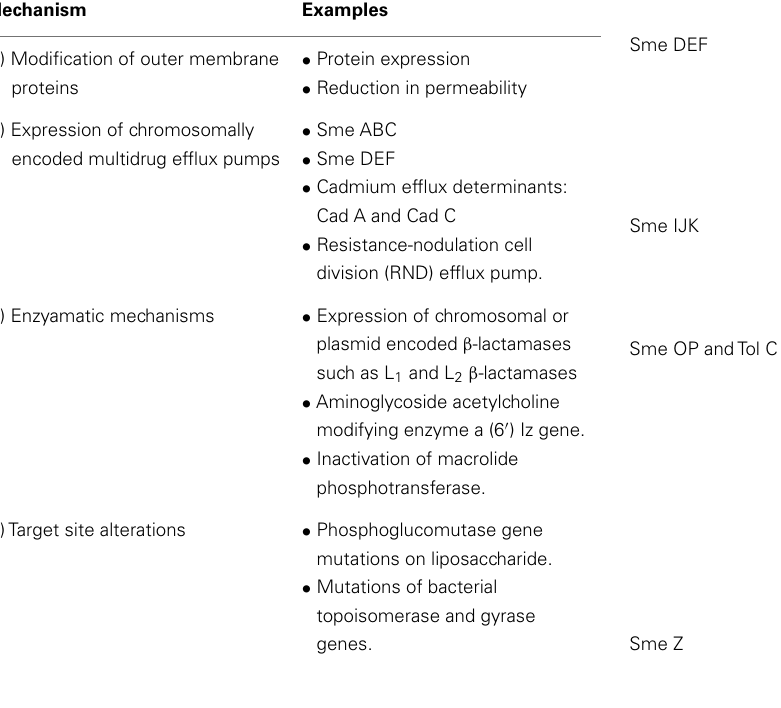
Table 4 | Mechanisms of S. maltophilia drug resistance . Mechanism